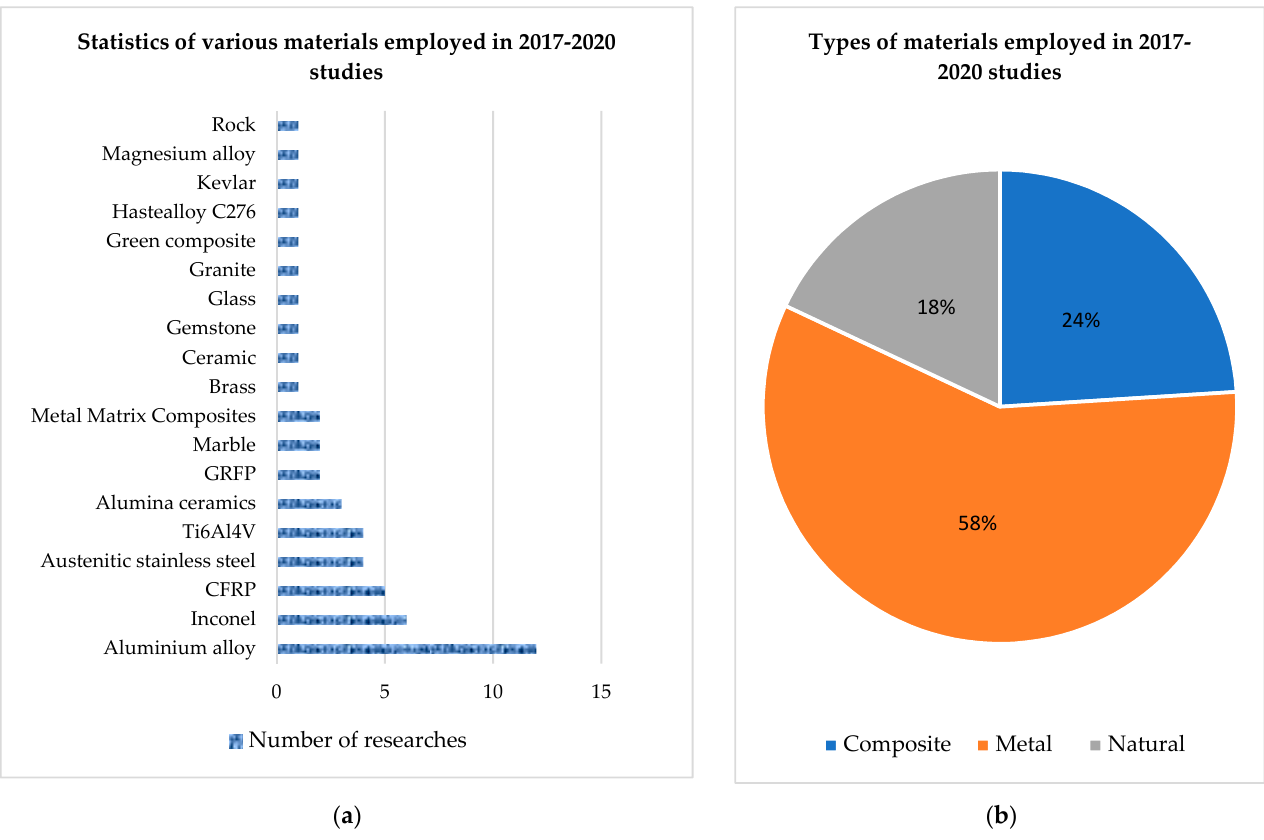
Figure 2. Statistics of ( a ) various workpieces employed in AWJM applications and ( b ) material type from 2017 to 2020 publications reviewed in this work.